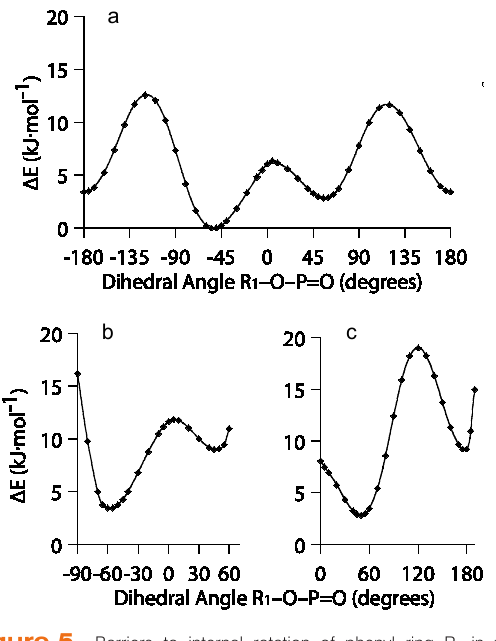
conformers.Barriers to internal rotation of phenyl ring R molecule of diphenyl chlorophosphate at +sc(a), –sc (b) and ap (c) orientations of phenyl ring R the DFT(PBE0/6-31G(2df,p) level of theory.